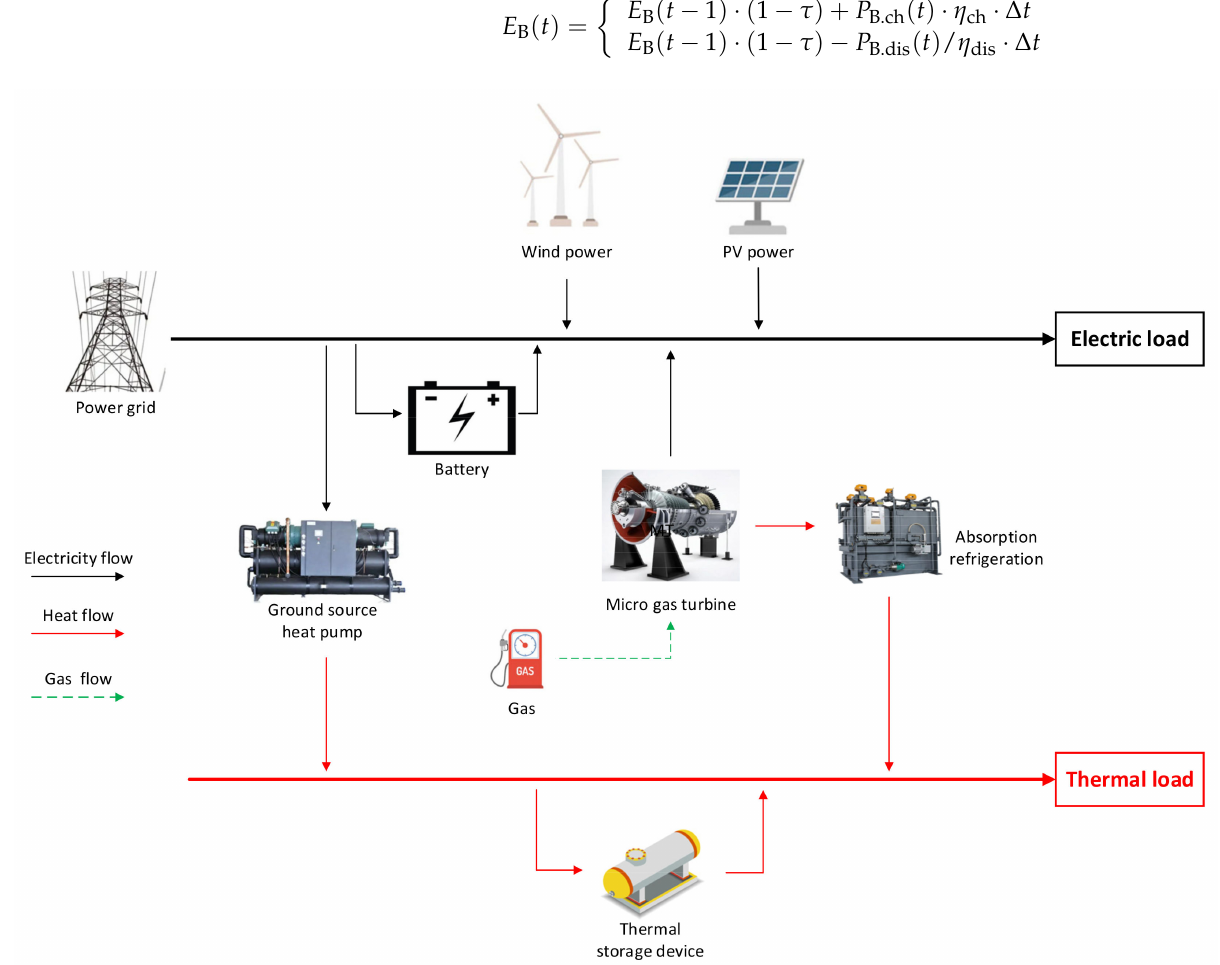
Figure 1. The structure of CHP